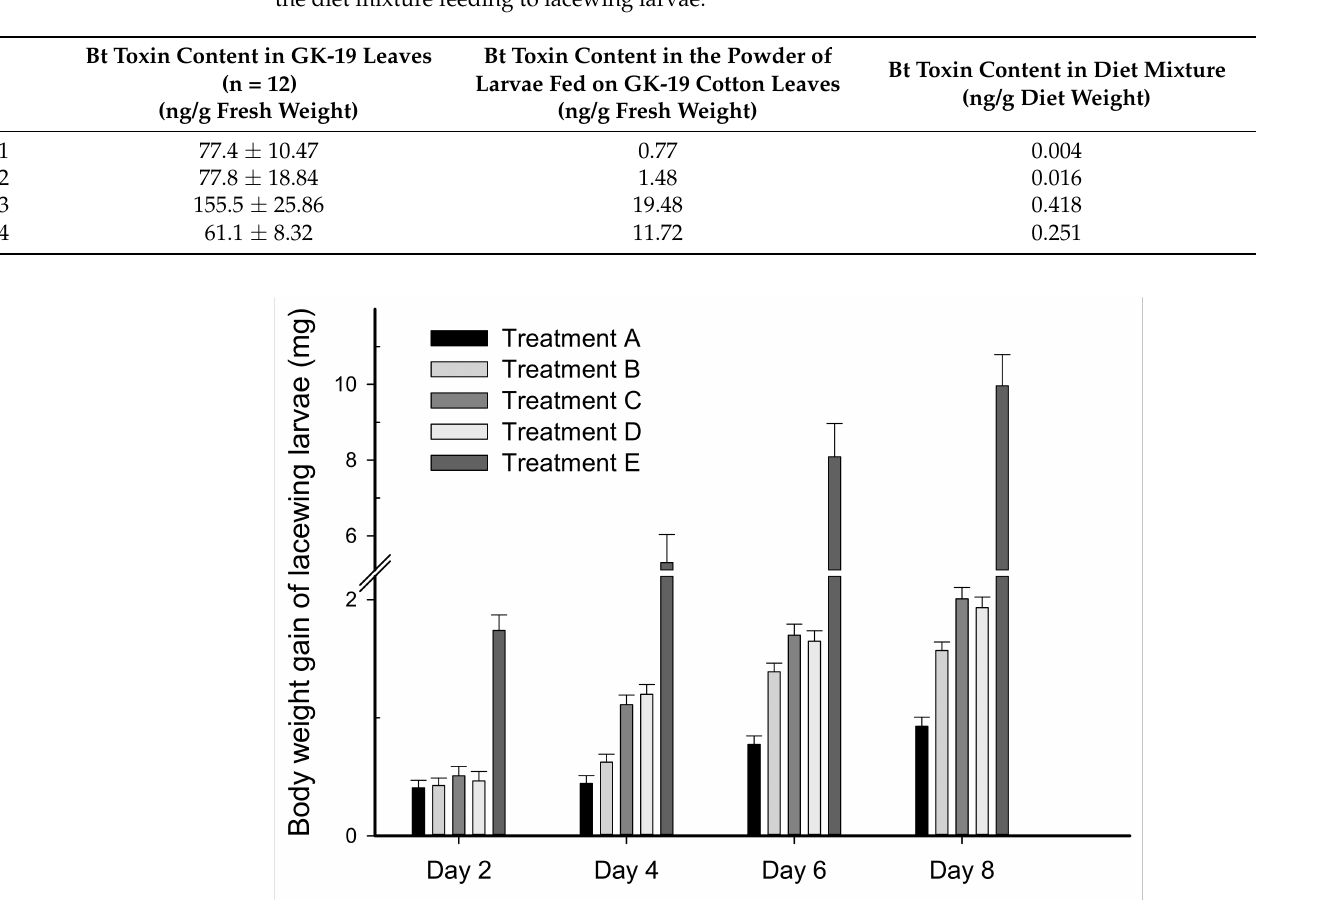
Table 1. Bt toxin contents in third expanded leaves from the plant apex of GK-19 at the six-leaf stage, in larval powder of beet armyworm (BAW) during the four times of Bt toxin accumulations and in the diet mixture feeding to lacewing larvae.